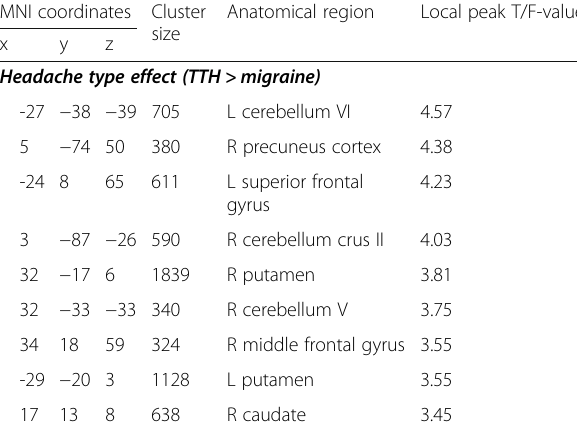
Table 3 A 2 × 2 ANCOVA analysis for the gray matter volume difference between TTH and